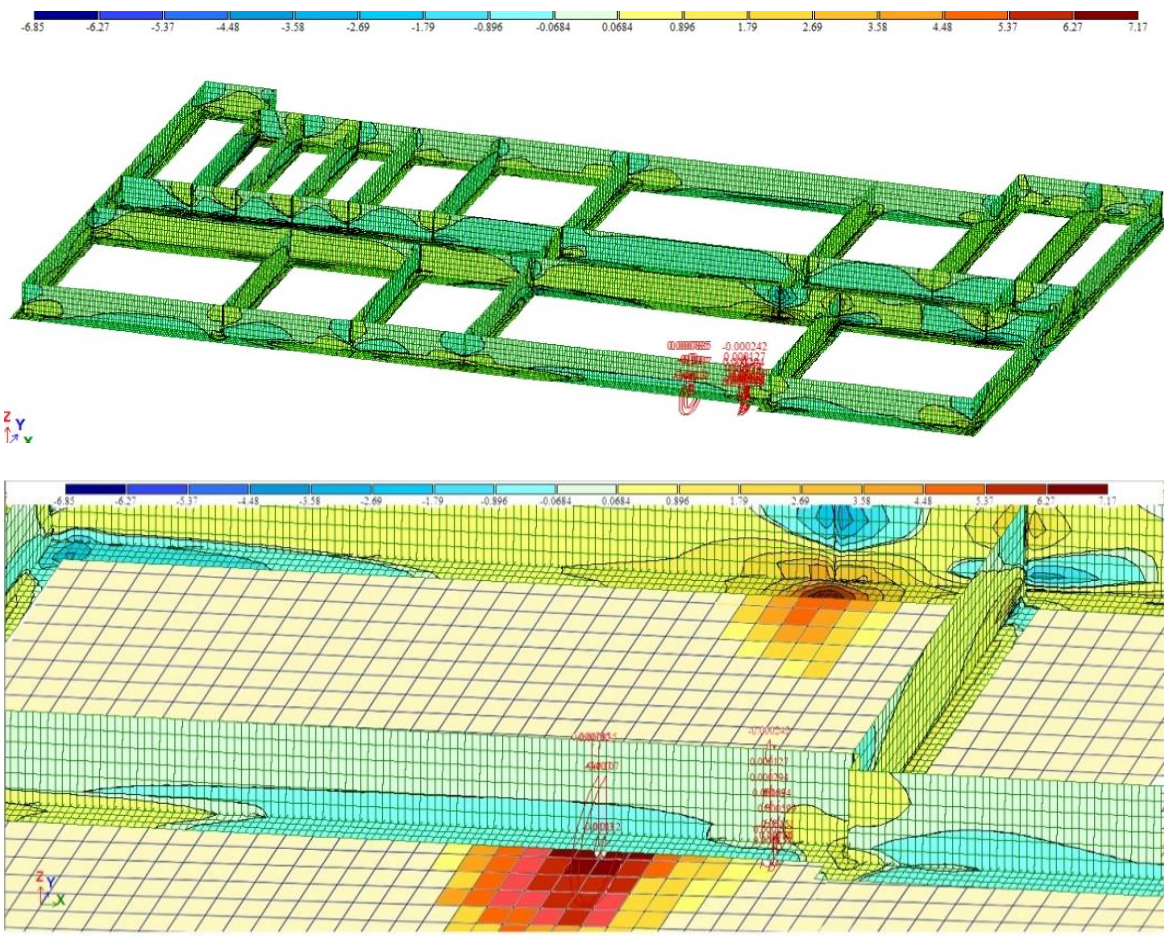
Figure 7. Simulation results for a soil base with a moisture content of W = 0.25.